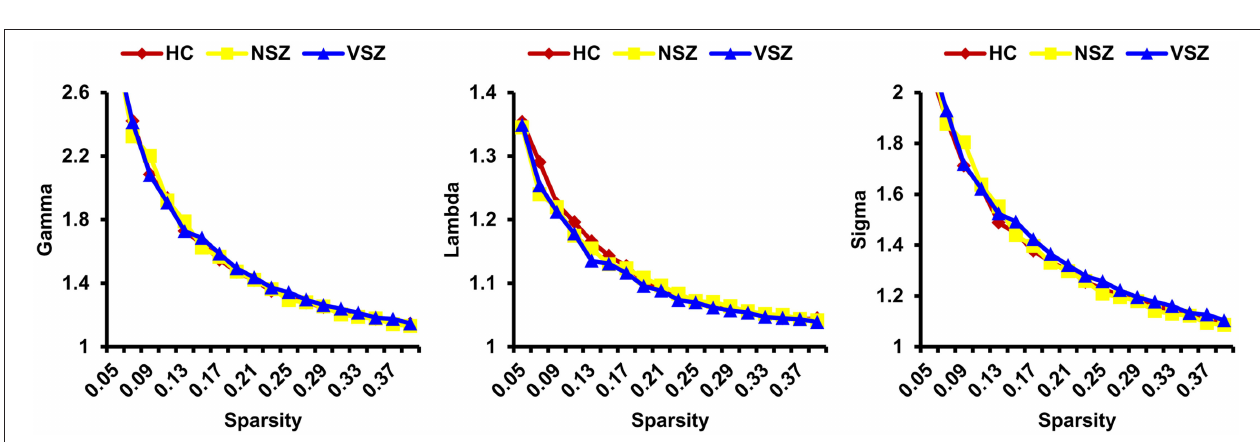
Eloc, assortativity, modularity, Cp, and nodal betweenness, no significant differences were noted among HCs, NSZ, and VSZ ( Supplementary Figure 1